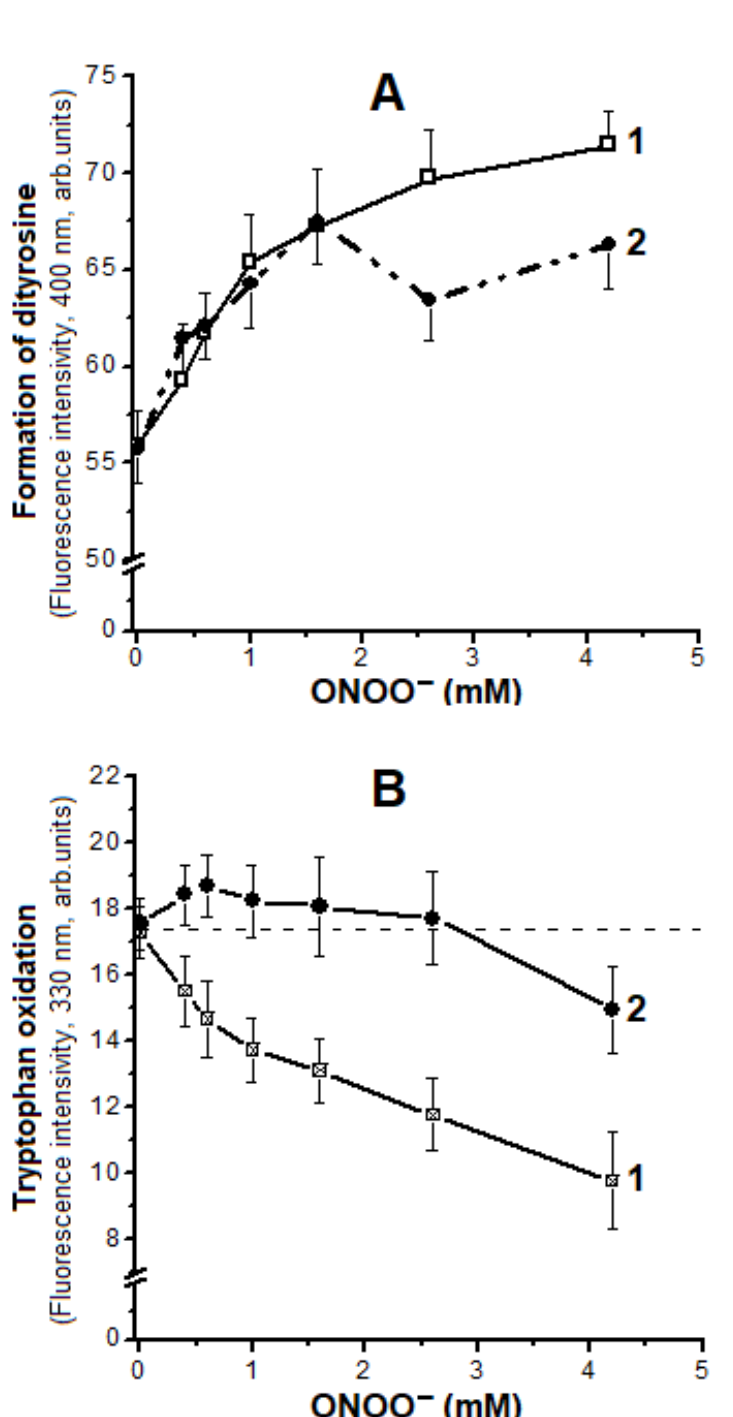
Figure 6. Changes in fluorescence during the formation of dityrosines ( A ), and during the oxidation of tryptophan residues ( B ) under peroxynitrite action. Curve 1—metHb, 2—Hb-DNICs. The composition of the reaction medium including peroxynitrite concentration is the same as in the legend to Figure 3. Tryptophan is another amino acid peroxynitrite target [46]. There are six tryptophan residues in Hb, of which only Trp37 β is located on the surface of the molecule. However, first of all, the Trp15 β residue is oxidized, and Trp37 β is oxidized only if the native protein structure is